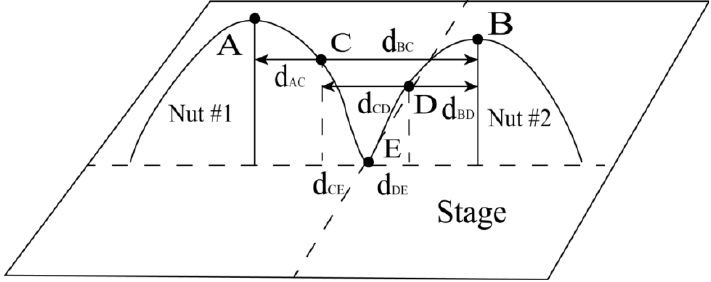
Figure 4. The spacing between points on two nuts.